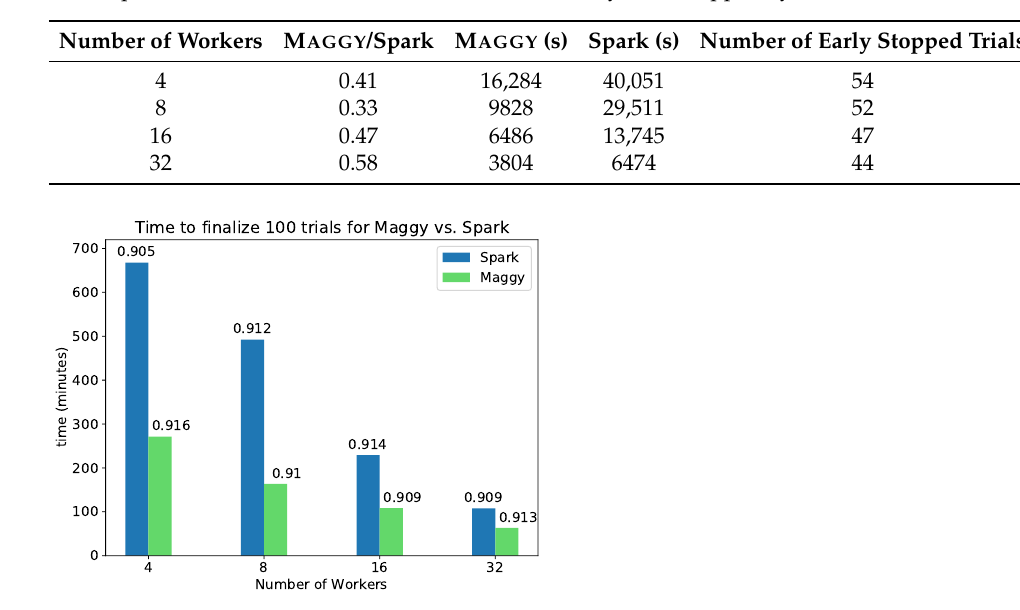
Table 2. Relative speedup of M AGGY over the general Spark implementation (the Experiment API), total experiment runtime in seconds, and number of early trials stopped by M AGGY [4].